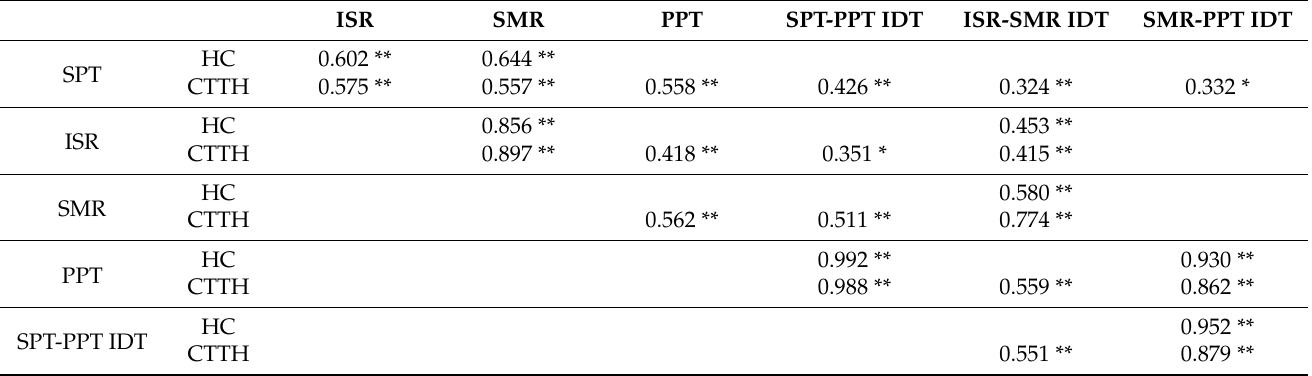
Figure 4. Box plots comparing subjective and objective electrophysiological responses and IDTs between healthy controls and CTTH patients. IDT, intensity difference between thresholds; ISR, initial sensory response; PPT, pain perception threshold; SMR, supramaximal response; SPT, sensory perception threshold. Table 2. Correlation between subjective and objective electrophysiological responses and IDTs in healthy controls and